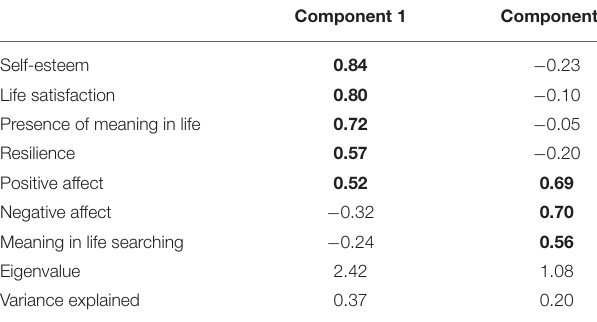
TABLE 2 | Principle component